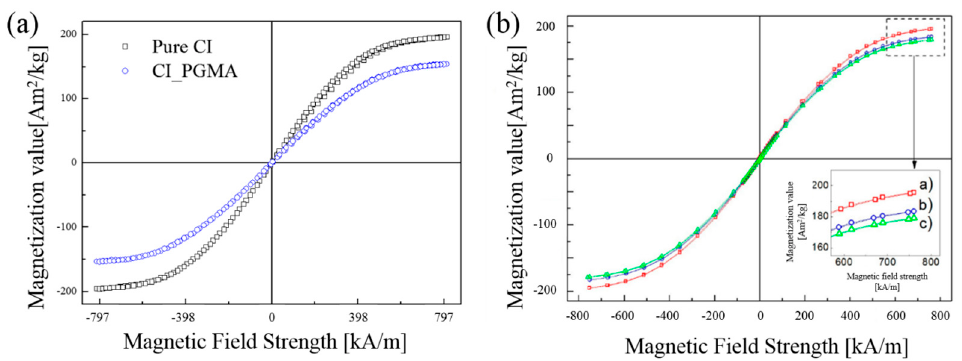
Figure 6. ( a ) VSM curves of pure CI (open dark square) particles and PGMA coated CI (open blue circle) particles [60] and ( b ) magnetization curves of a—bare CI, b—CI-g-PHEMATMS-1 (11 nm), and c—CI-g-PHEMATMS-2 (22 nm) particles obtained via VSM [118].